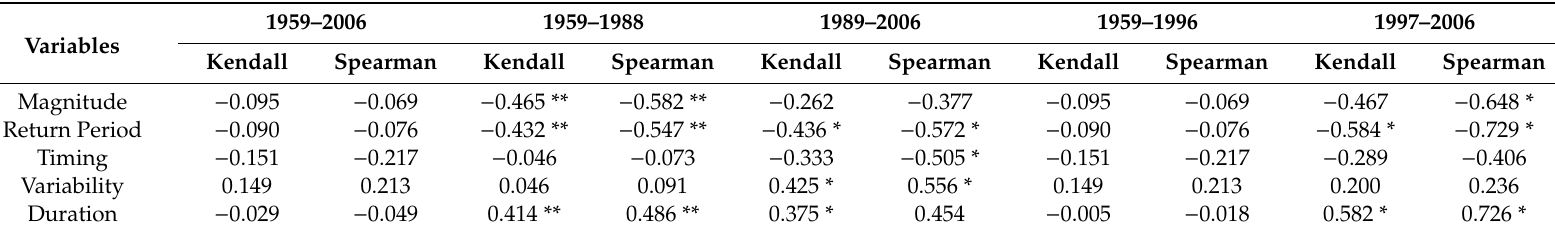
Table 5. Trends analysis for low flow regime components.